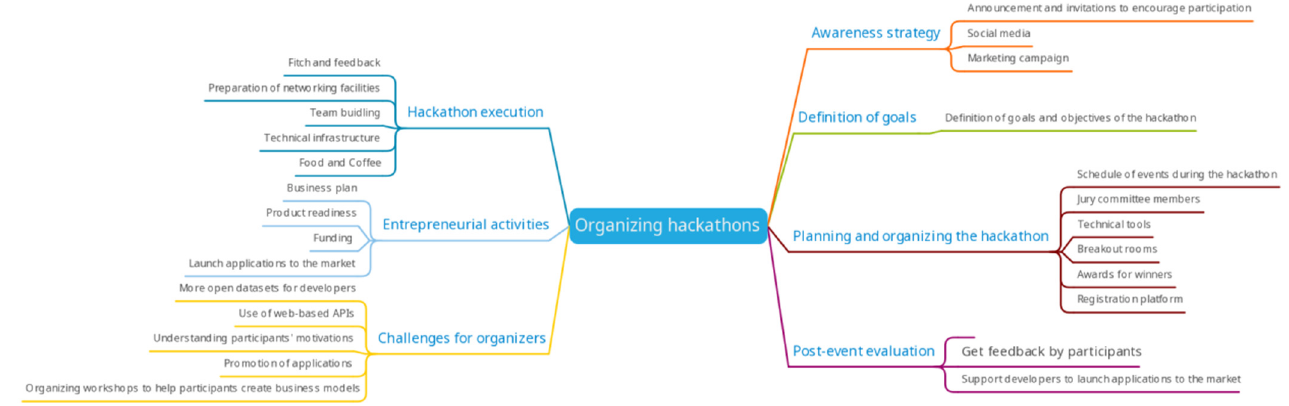
Figure 5. Mind map visualization for organizing open data hackathons.